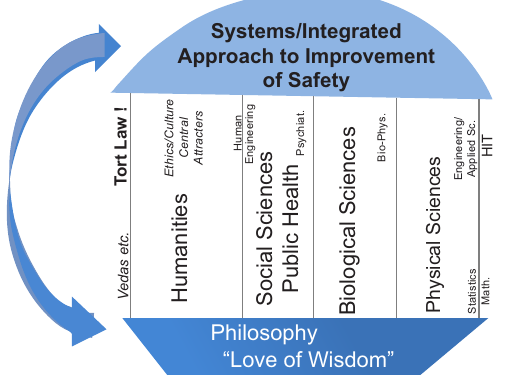
Figure 3. Systems thinking integrating information and knowledge from various domains to avoid